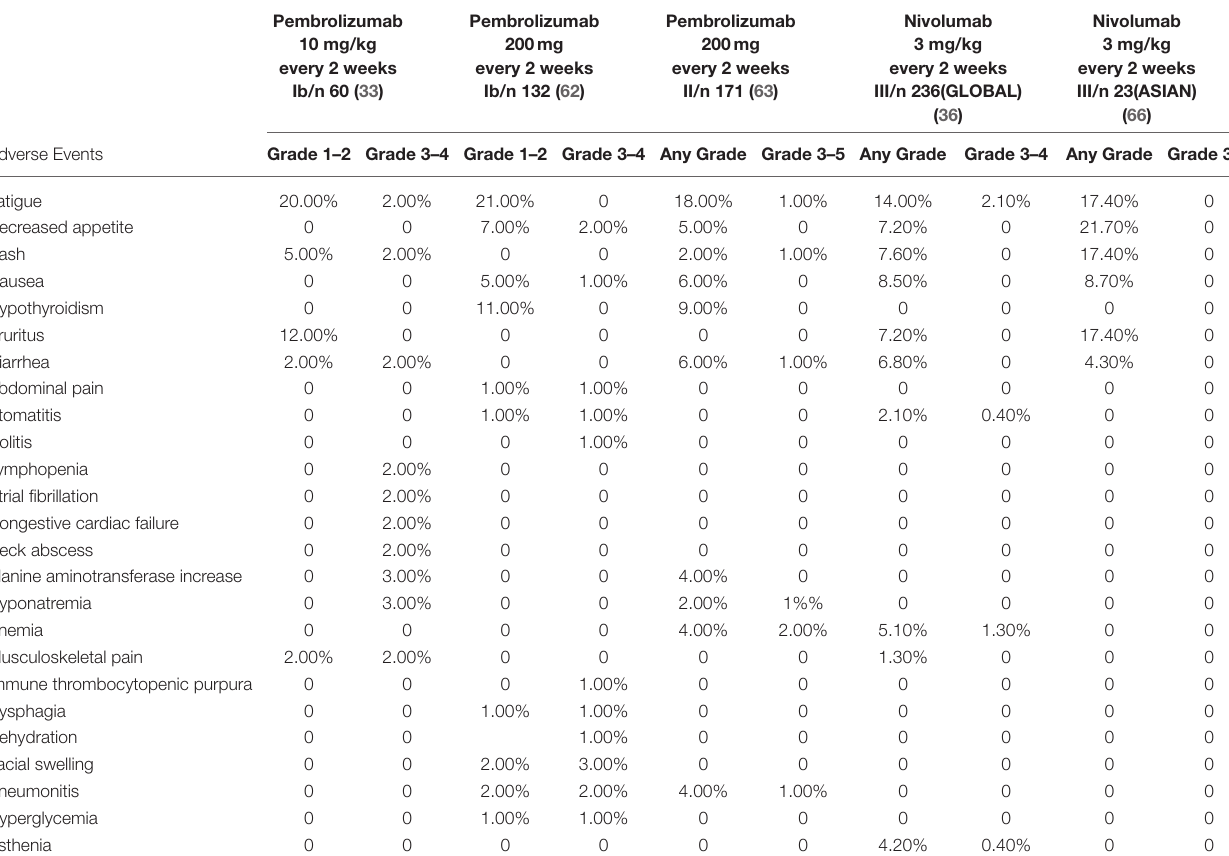
TABLE 4 | Incidents of treatment-related adverse events occurring in patients with head and neck